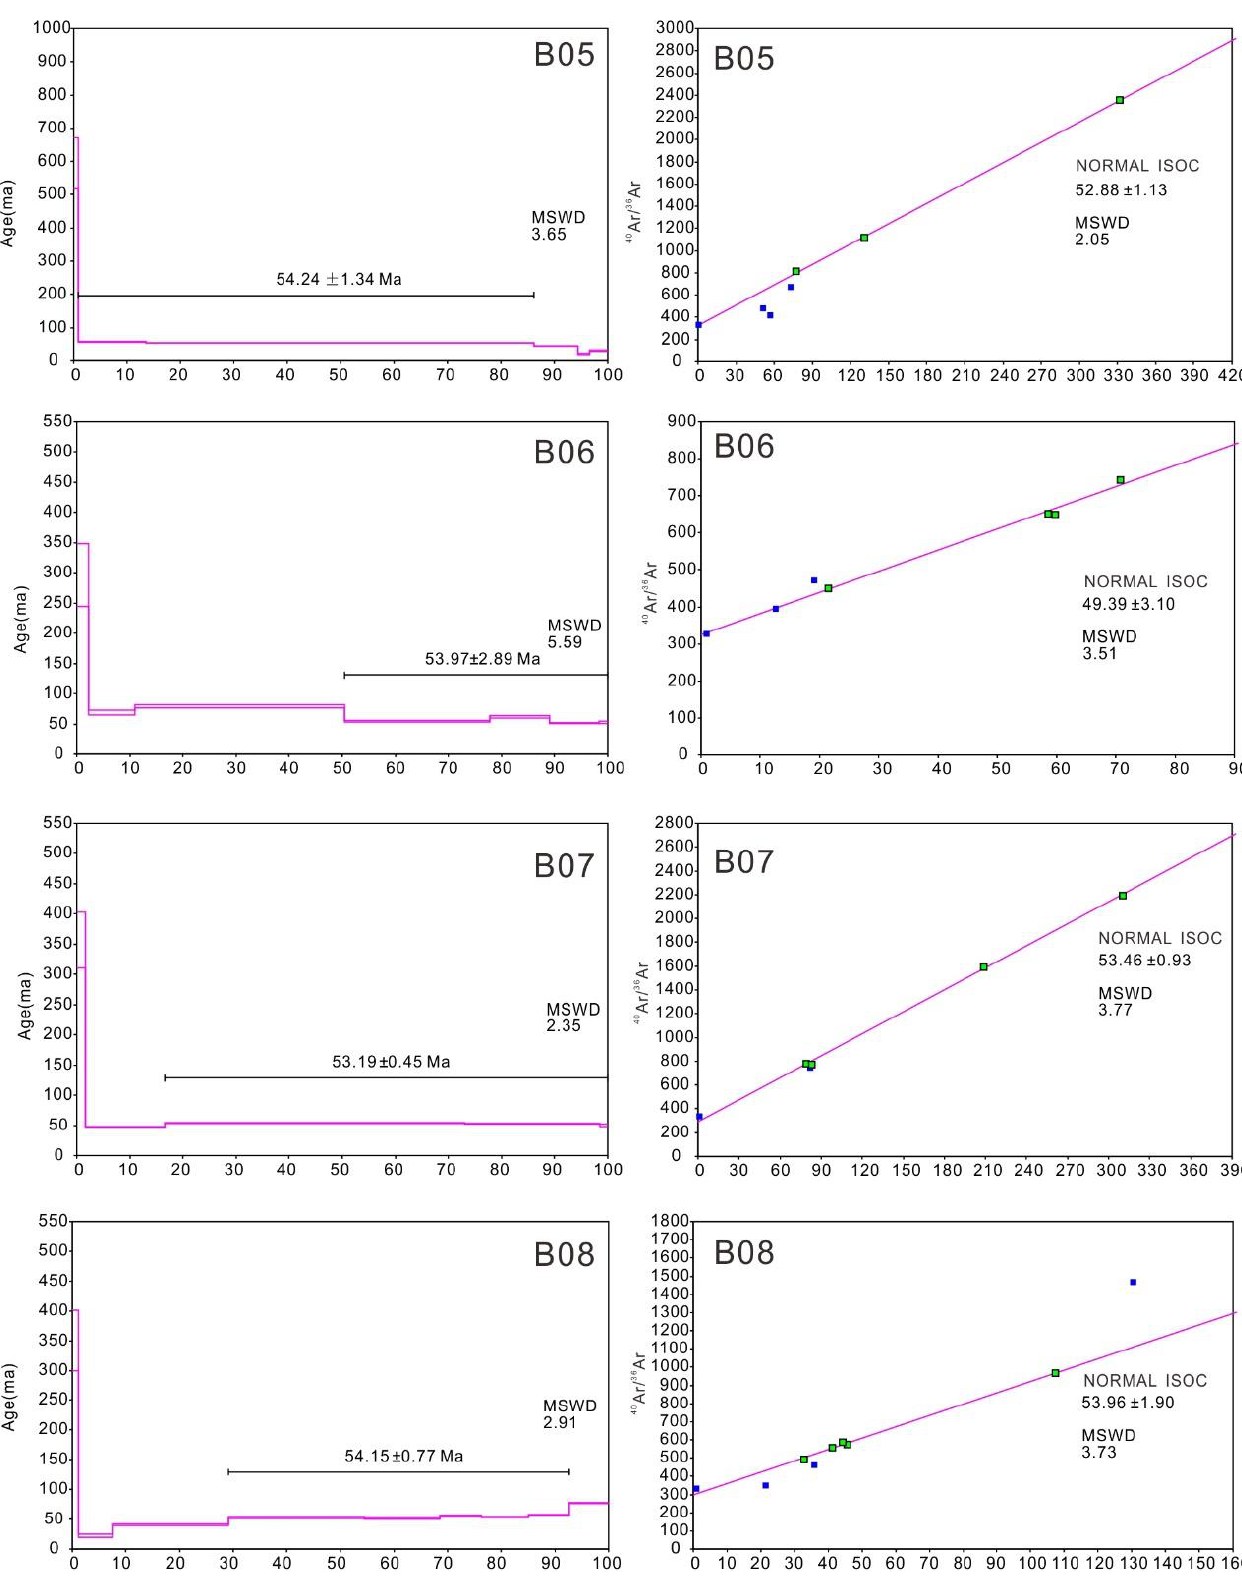
Figure 8. 40 Ar/ 39 Ar age spectra and isochron ages (Sample B05-B08) of the volcanic rocks from the Jiangling Basin.